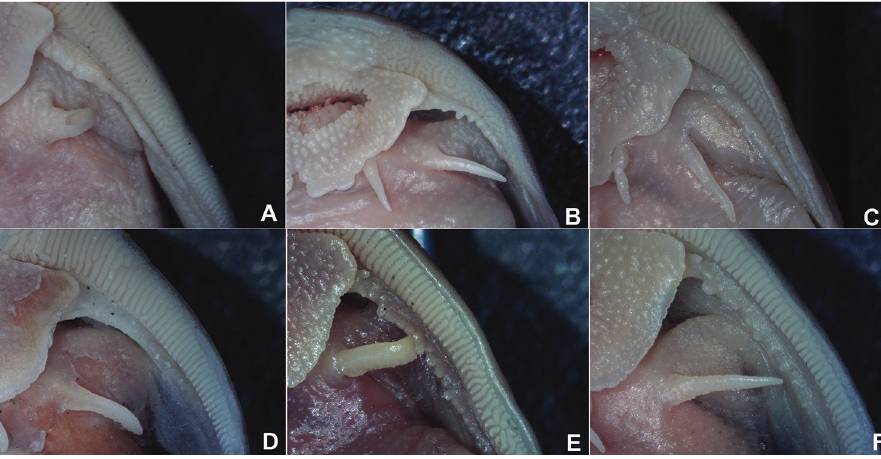
Figure 3. Comparison of posterior margin of maxillary barbel of Oreoglanis species. A O. jingdongensis , KIZ 200104003, holotype, 109.1 mm SL B O. immaculatus , KIZ 200261015, holotype, 54.2 mm SL C O. insignis, KIZ 9810191, holotype, 66.7 mm SL D O. hponkanensis , KIZ CXY20150126, paratype, 78.88 mm SL E O. macropterus , KIZ 2004000834, 79.6 mm SL F O. setiger , KIZ 2016000859, 90.0 mm